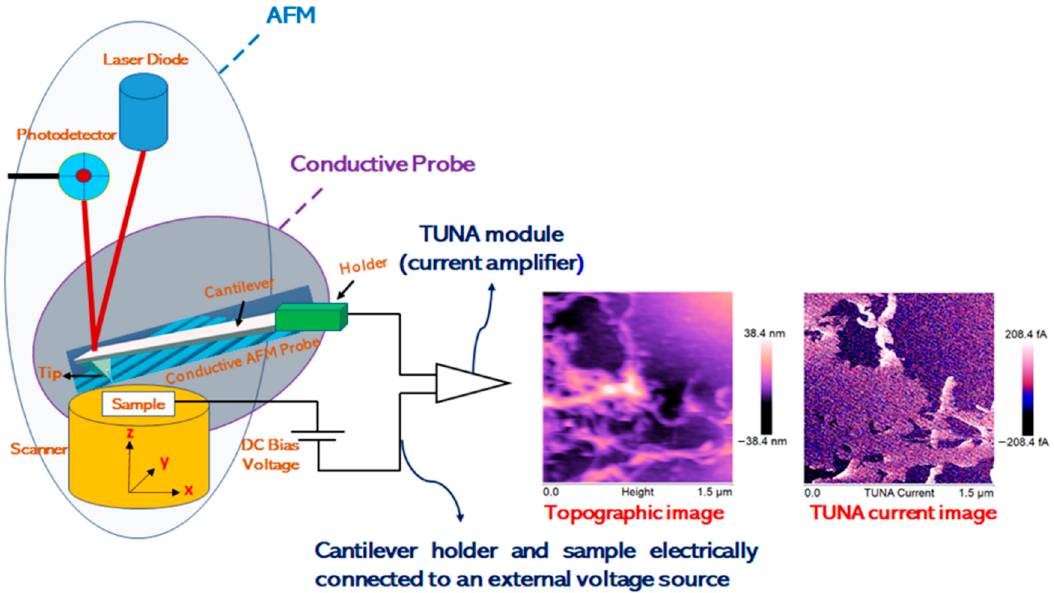
Figure 2. Schematic drawing of TUNA apparatus.